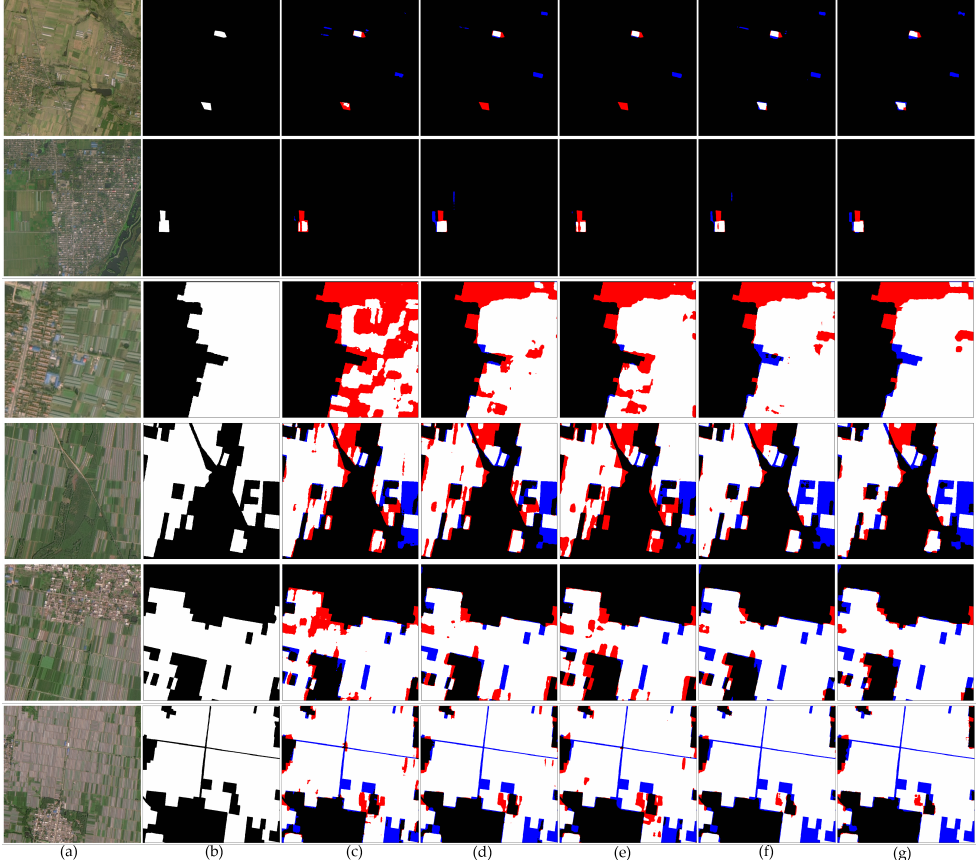
Figure 5. Examples of greenhouse extraction ablation experiments. Red indicates missed detection (the label value is a greenhouse that is not recognized), and blue indicates false detection (the label value is not a greenhouse but is incorrectly identified as a greenhouse). From left to right: ( a ) Gaofen-1 satellite image; ( b ) ground truth; ( c ) UNet; ( d ) UNet-SPCLSTM; ( e ) UNet-MultiTask; ( f ) UNet-SPCLSTM-MultiTask; ( g )